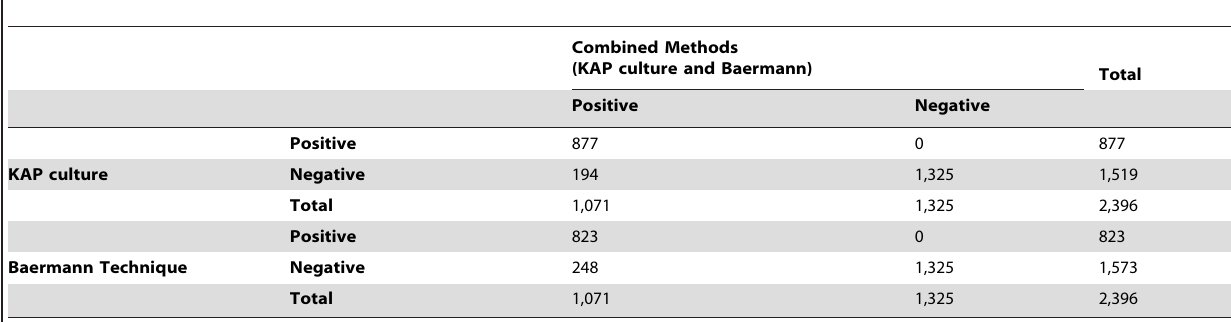
Table 1. Koga agar plate (KAP) culture and Baermann method for the detection of S. stercoralis in 2,396 participants, Preah Vihear province, Cambodia, 2010.